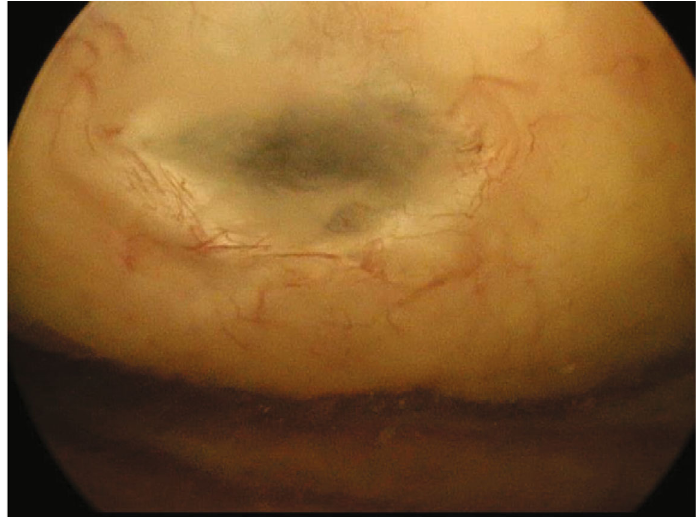
Figure 2: Intraoperative fl exible cystogram — rupture of bladder dome.